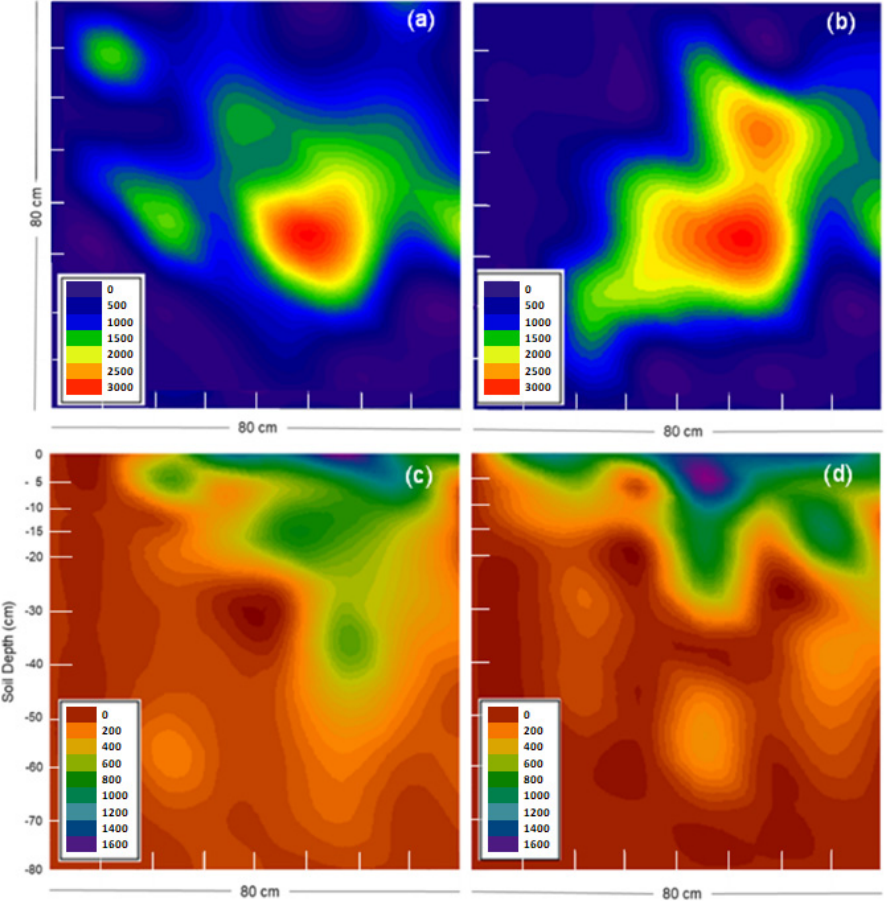
Figure 6. Distribution pattern of Br − concentration on soil surface and soil profile following simula- tion of dairy cow urination on year 1 ( a , c ) and year 2 ( b , d ). Different colors represent different Br − concentrations (mg kg − 1 ). Images c and d represent a layer in the middle of surface sampled into the